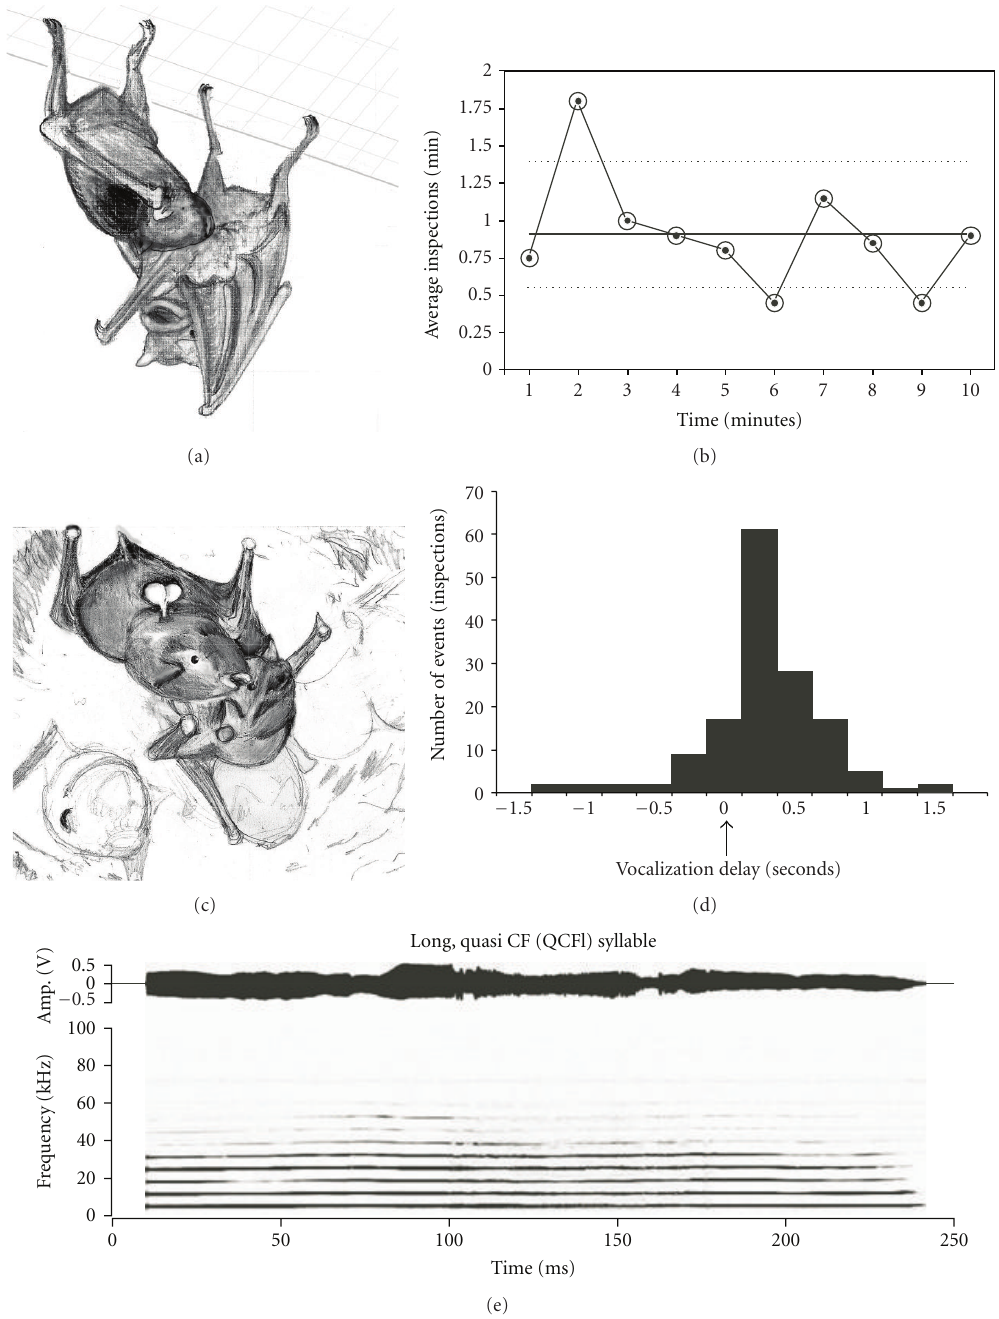
Figure 6: Appeasement behavior in mustached bats. (a) A male inspecting a female. (b) Inspection rate after a disturbance. The grey horizontal line shows the mean rate, and the dotted lines show the 95% confidence intervals. The rate is significantly higher in the second minute. (c) Two males “kissing.” (d) A histogram showing the temporal relationship of vocalization with the enactment of the kissing behavior. Zero time is indicated by the arrow and corresponds to the time of perceived contact of male’s nose with the genital region of the female. (e) The amplitude envelope (above) and spectrogram (below) of a QCFl